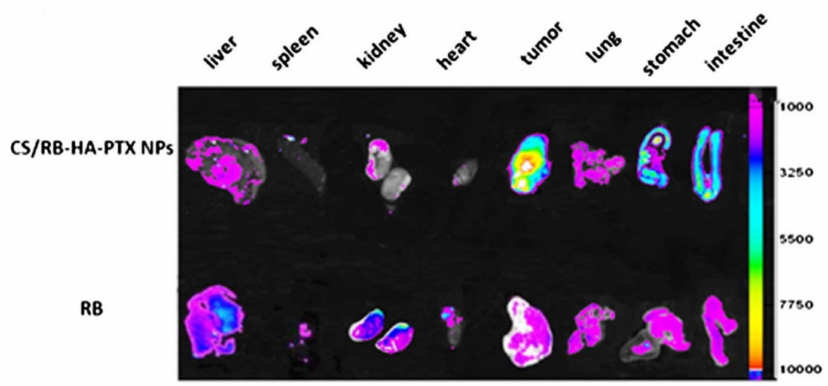
Figure 5. In vivo imaging of the tumour and various organs, showing the specificity of the tar- geted tumour delivery when using chitosan/rhodamine B-hyaluronic acid-paclitaxel nanoparticles (CS/RB-HA-PTX NPs) over rhodamine B (RB) taken orally. Adapted with permission from Ref. [66]. Copyright 2013 Springer